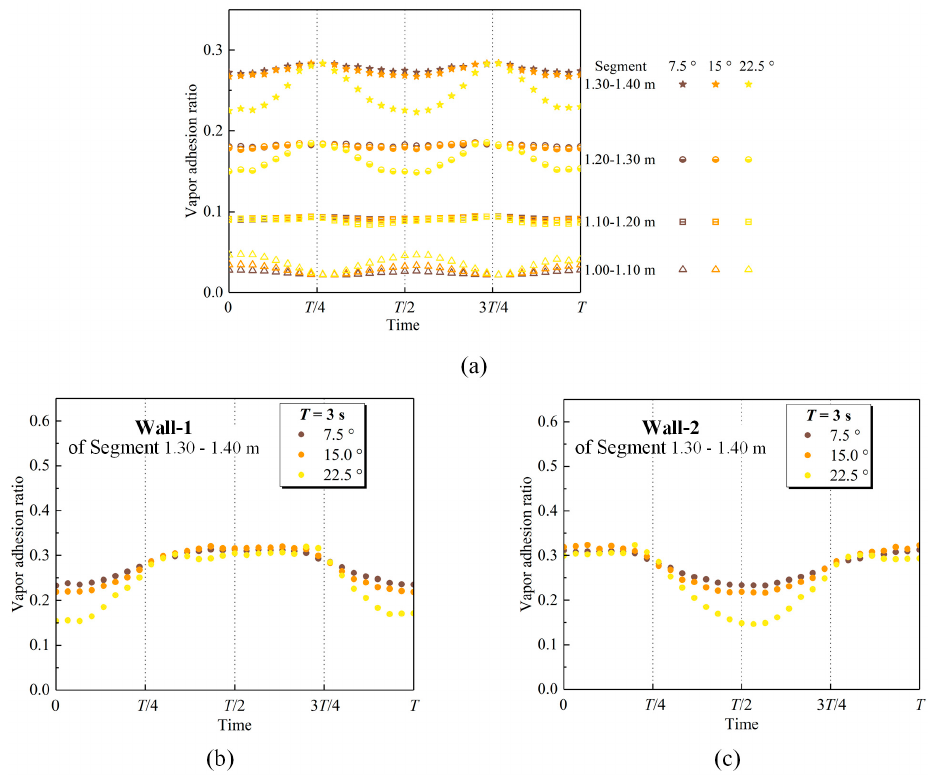
Figure 14. Effect of the amplitude on the vapor adhesion ratio. ( a ) Segment; ( b ) Wall-1 of Segment 1.30–1.40 m; ( c ) Wall-2 of Segment 1.30–1.40 m. 1.30–1.40 m; ( c ) Wall-2 of Segment 1.30–1.40